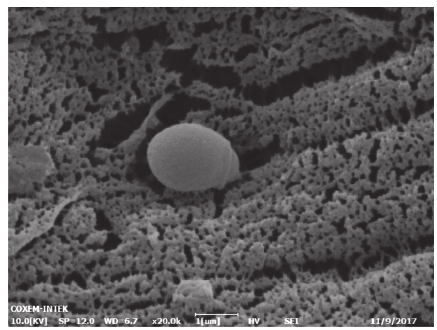
Figure 9: T. gondii oocyst morphology.